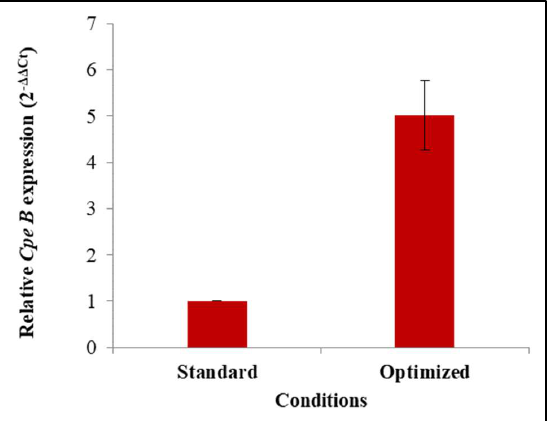
Figure 4. cpeB gene expression levels for Rhodomonas sp. using different culture conditions .